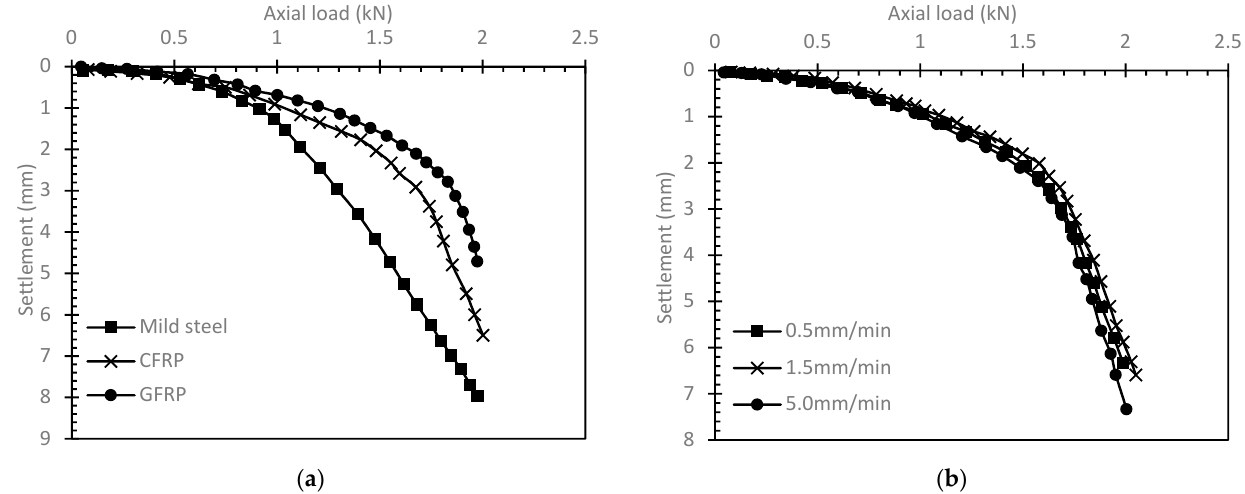
Table 4. Surface roughness (R t ) of different types of FRP.